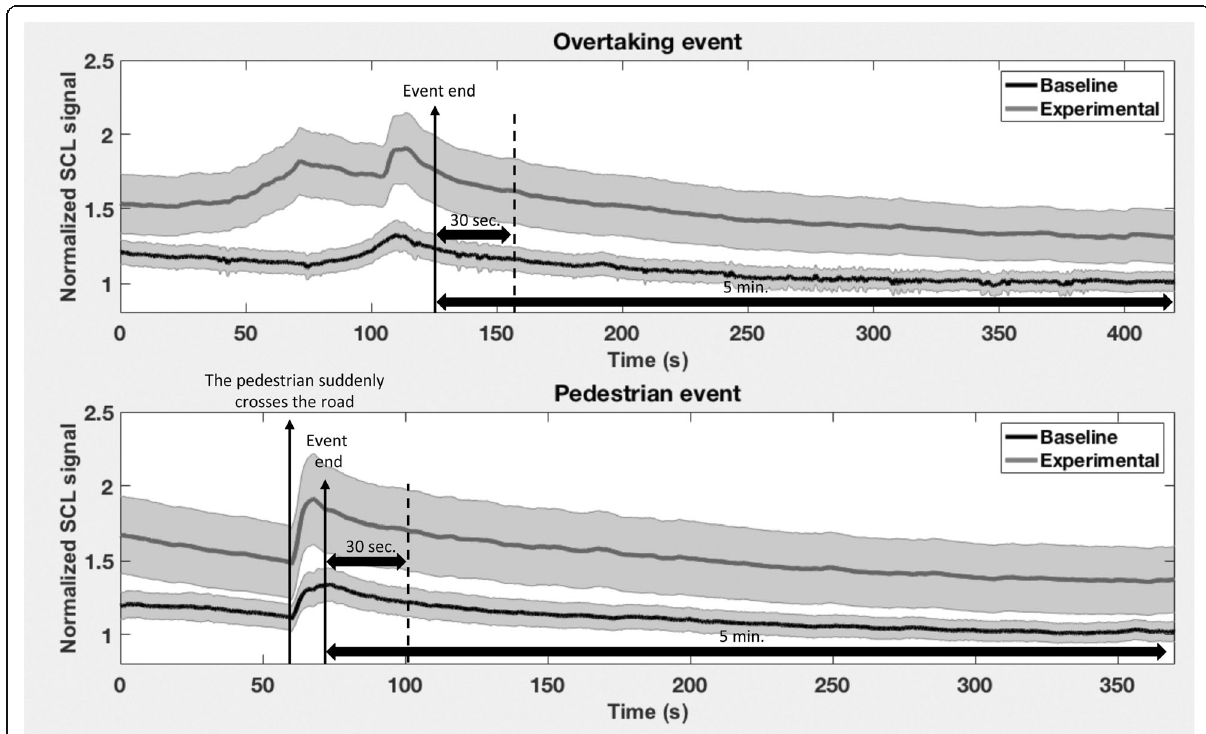
Fig. 1 Mean normalized skin conductance level as a function of time, session and event. For a better visualization, the normalized skin conductance level has been averaged across participant. In grey, the plot standard error envelopes. Note also that the duration of the pedestrian event (i.e., duration between the begining of the crossing and the end of the event) was not exactly the same for each participant, depending of the driver ’ s avoidance